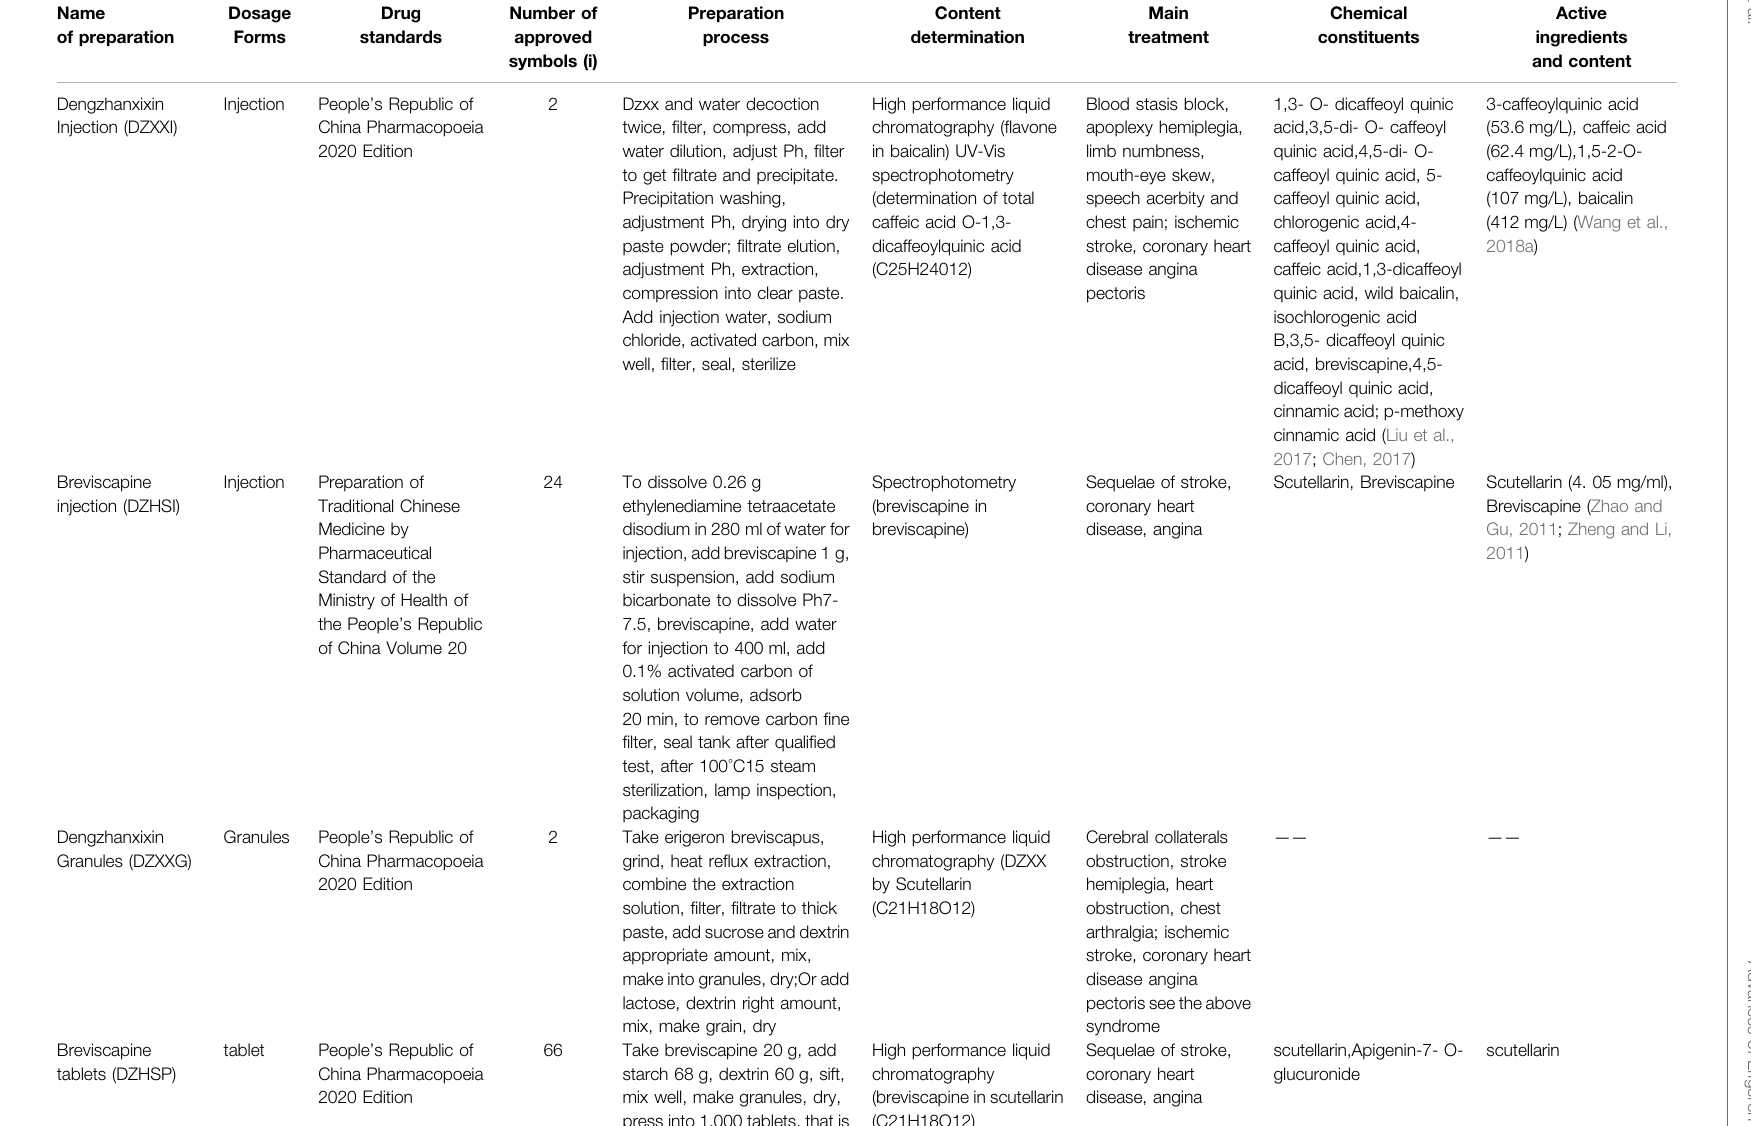
TABLE 2 | Information of DZXX series preparations. Name of